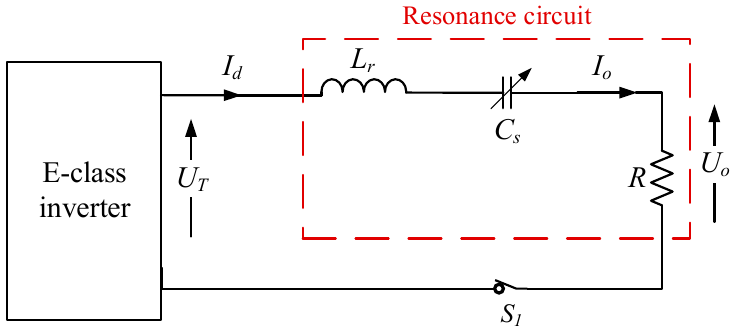
Figure 4. The structural schema of the considered CPT system.